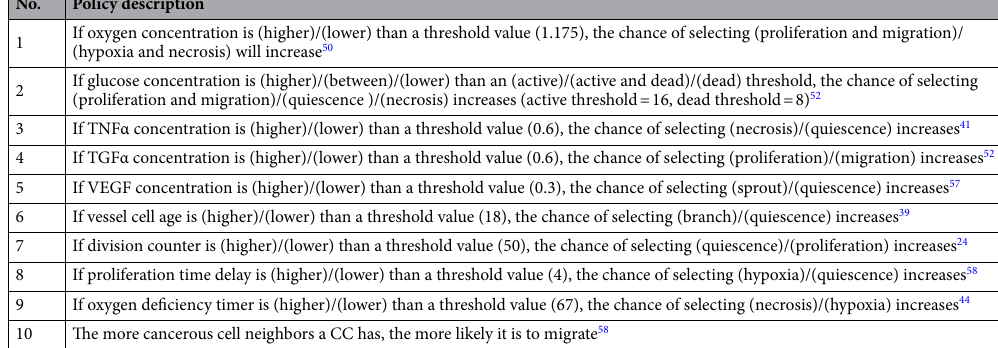
Table 2. Policies for the multiscale computational model used during simulation, which are functional map states and probability distributions for possible actions. The goal of the agent is to optimize future rewards and, specifically, to find a policy that maximize